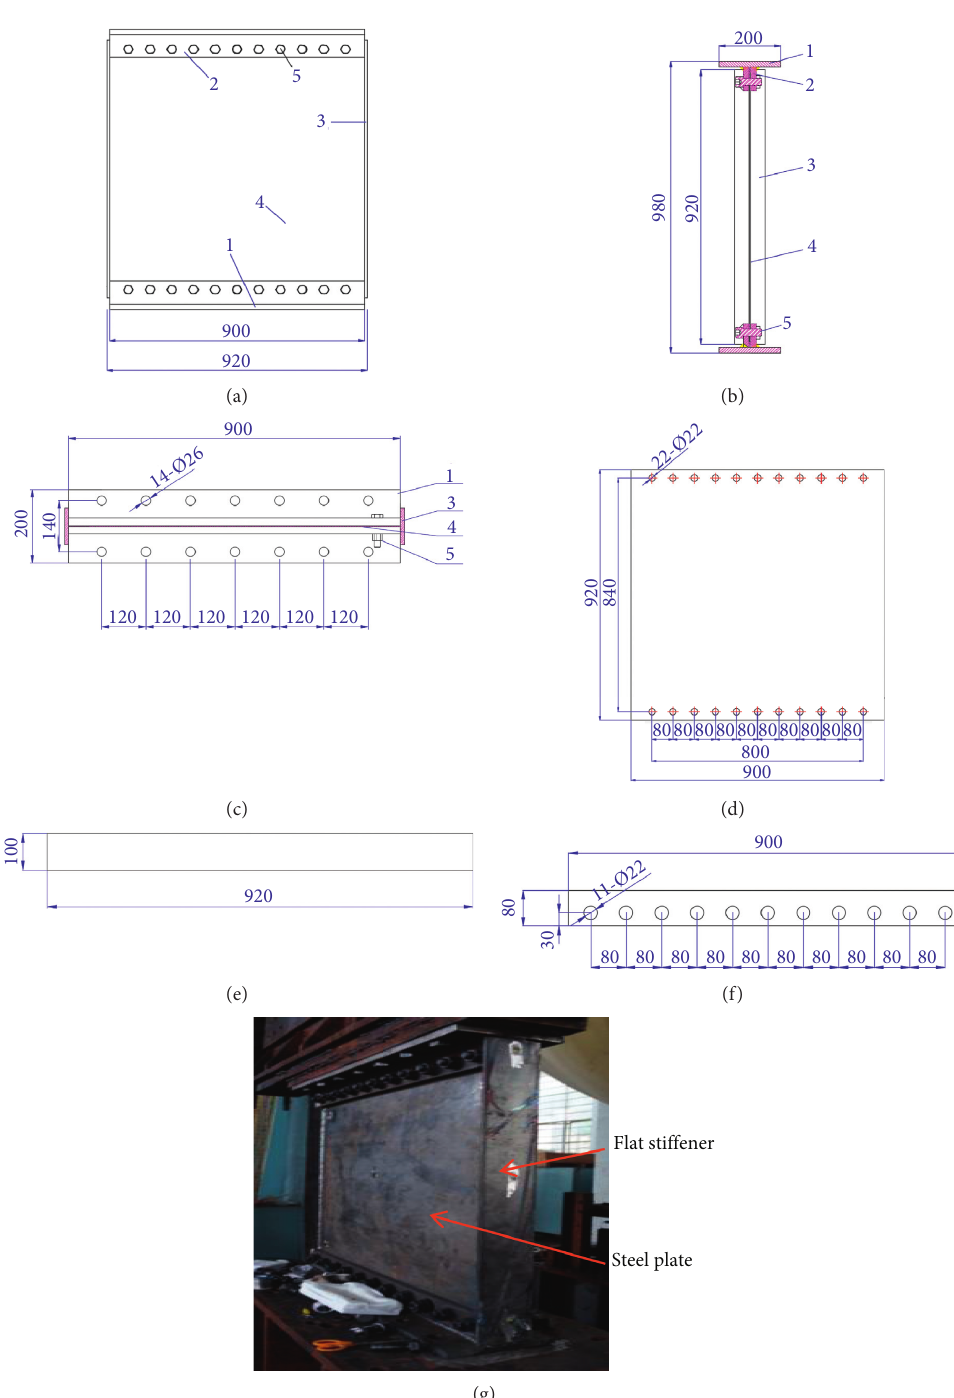
Figure 6: Construction of SPSW specimen. (a) Plan. (b) Side profile. (c) Top profile. (d) Infilled steel plate. (e) Flat stiffener. (f) Fish plate. (g) Photograph of SPSW